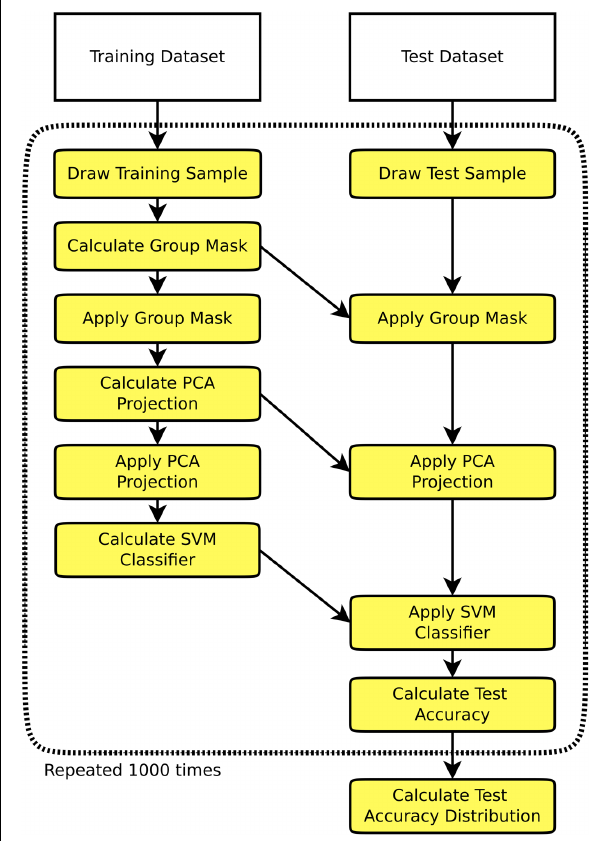
FIGURE 1 | Flowchart of one simulation run consisting of the selection of a training set and a test set independent of the training set, training a classifier on the training set, and testing the classifier on the test set. This procedure is repeated 1000 times to derive an empiric distribution of the test accuracy for a given training sample size and a given test sample